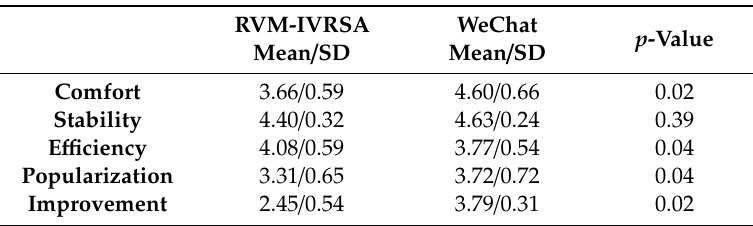
Table 1. User satisfaction